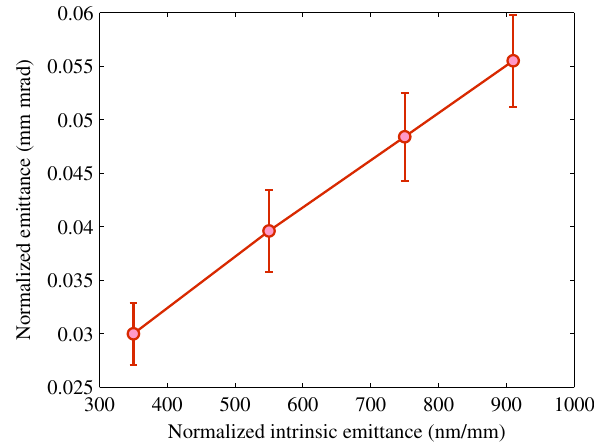
FIG. 15. Optimized emittance along the central part of the bunch at the end of the SwissFEL injector for 10 pC case versus the normalized intrinsic emittance. The error bars indicate the standard deviation of the emittance along a (cid:2) 0 . 5 mm interval in the bunch.